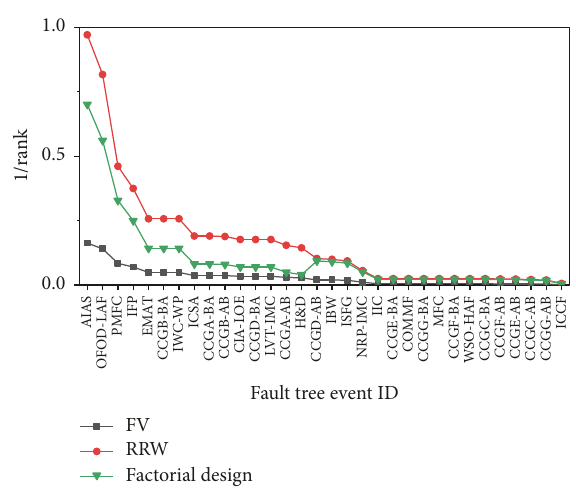
Figure 12: Importance measure-event’s ranking based on accident frequency.